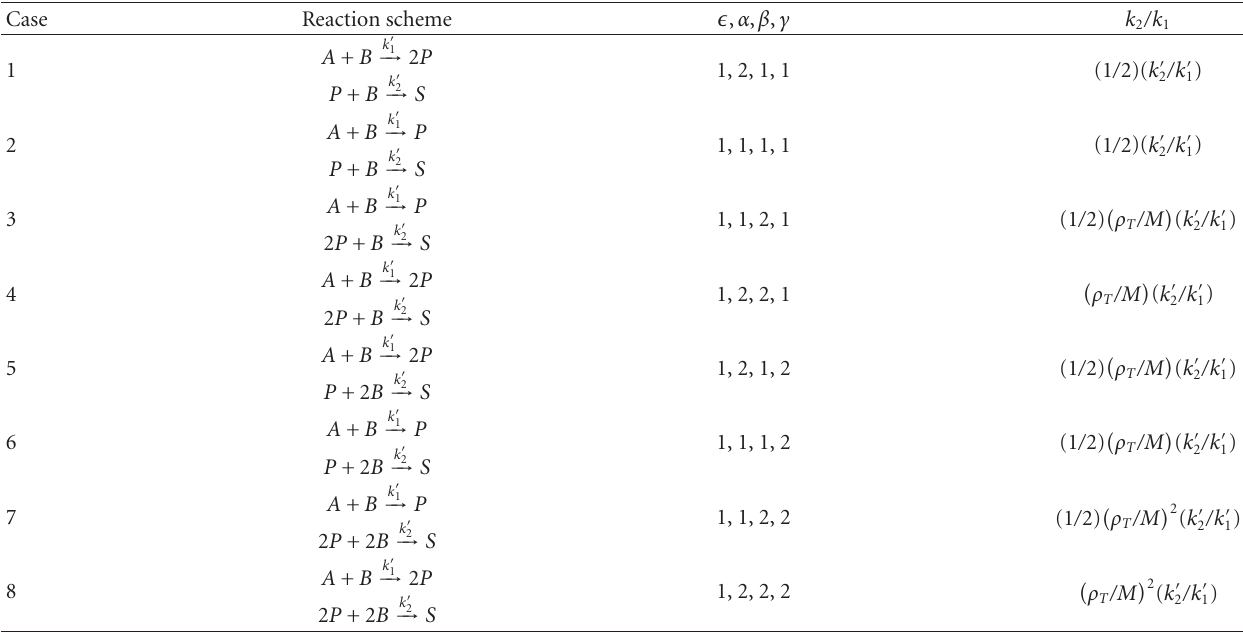
Table 2: Stoichiometries of reaction schemes and the corresponding dimensionless reaction rate ratio for the eight di ff erent C-C reactions. Da was always Da = k (cid:2) 1 ( ρ T /M )( L 2 B /D B ).